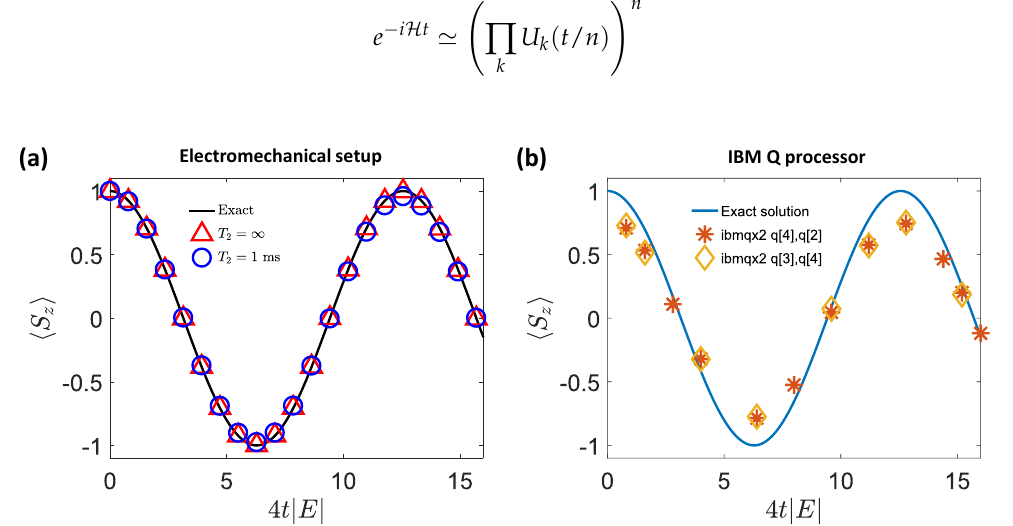
Figure 1. Digital quantum simulation of the tunnelling of the total magnetization in a spin-1 Hamiltonian. ( a ) Numerical results for the proposed electromechanical set-up, for different values of the NRs T 2 time. ( b ) Experimental data from the IBM Q ibmqx2-Yorktown real backend, for different choices of the pair of qubits selected on the